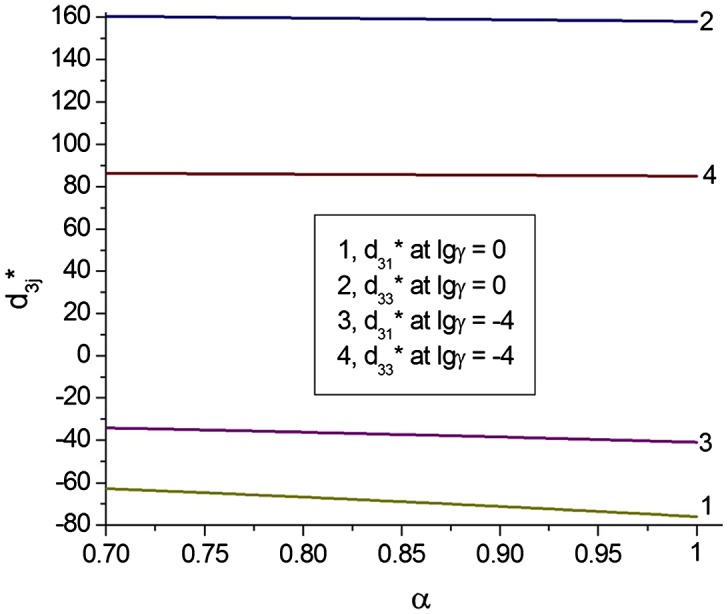
Piezoelectric coefficients d3j* (in pC/N) of the poled porous BaTiO3 material (3–0 connectivity, see the model in Figure 3(a)) at the fixed mobility of 90° domain walls in FC grains. Calculations were performed using full sets of electromechanical constants [24] of the poled monolithic BaTiO3 FC at either lg(γ) = 0 (curves 1 and 2, moderate mobility of 90° domain walls) or lg(γ) = –4 (curves 3 and 4, low mobility of 90° domain walls).